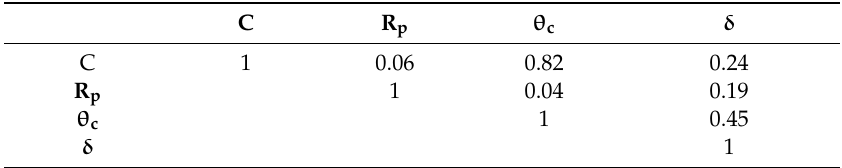
Figure 1. Persistence of soil water repellency (SWR) (Log water drop penetration time (WDPT) (Log s)) as a function of water content θ (g g − 1 ) measured during dying soil samples and corresponding fitted curve using the Equation (1) for the first six soils from Table 1: ( a ) Pallic Orthic Brown, ( b ) Typic Orthic Pumice, ( c ) Typic Immature Pallic, ( d ) Typic Orthic Pumice, ( e ) Mottled Argillic Pallic, ( f ) Pallic Orthic Brown. Table 2. Coe ffi cient of determination of linear regressions between C (%) and the model parameters R p ( Log s ) , θ c (g g − 1 ) and δ